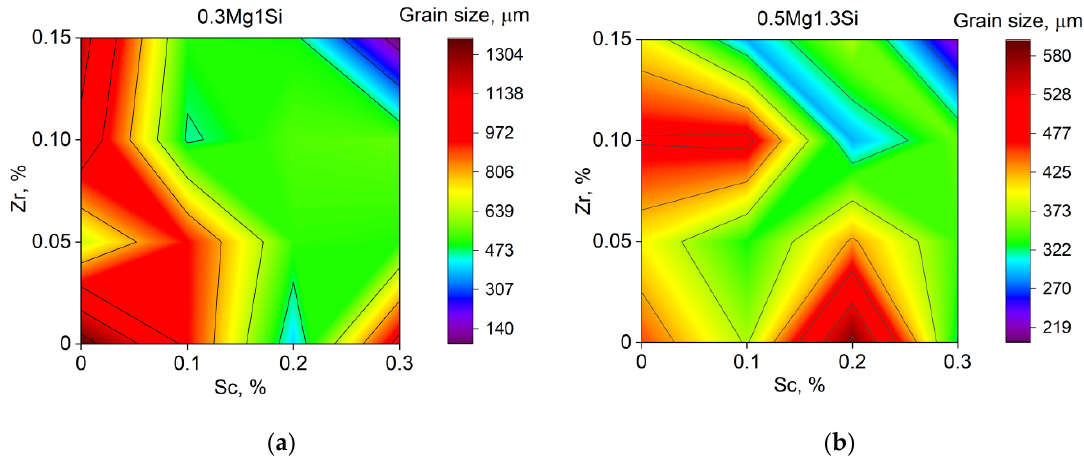
Figure 3. Grain size at complex alloying with small Sc and Zr additives ( a ) in alloys based on Al 0.3 Mg 1 Si, ( b ) on AL 0.5 Mg 1.3 Si.